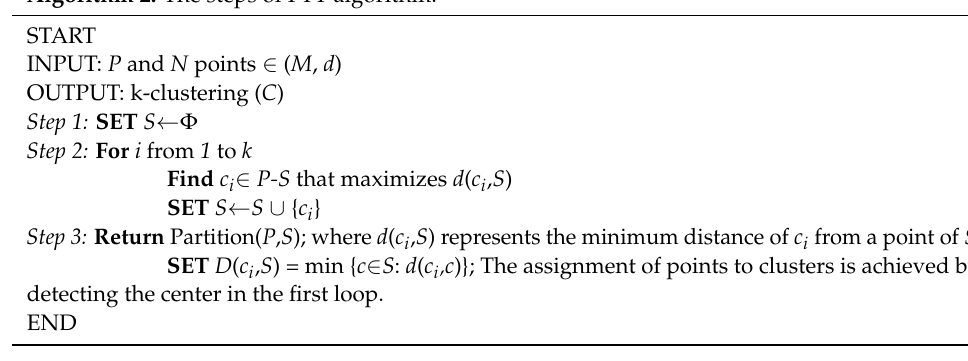
Algorithm 2: The steps of FTT